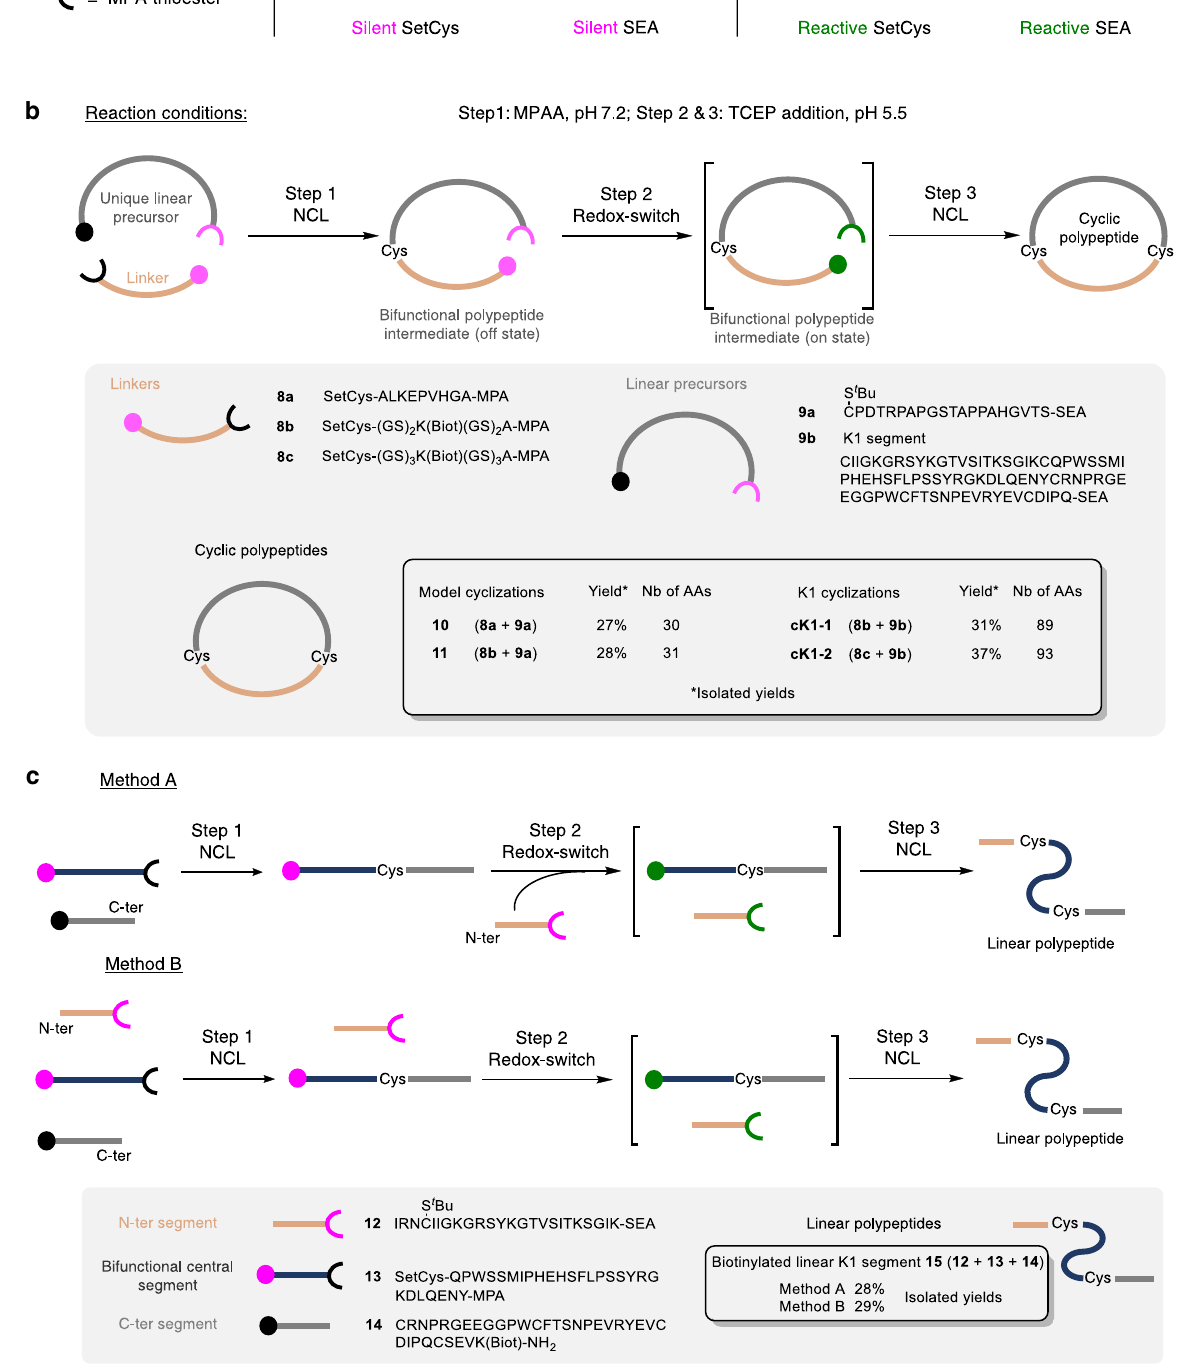
Fig. 5 SetCys redox switch enables the straightforward synthesis of linear and cyclic proteins in one-pot. a Schematic representations of peptidic N- and C-ter extremities. b One-pot grafting of a peptide linker to a unique linear precursor yields cyclic polypeptides. Application to the total synthesis of cyclic and biotinylated analogs of HGF/SF K1 domain ( cK1-1 , cK1-2 ). c One-pot synthesis of linear K1